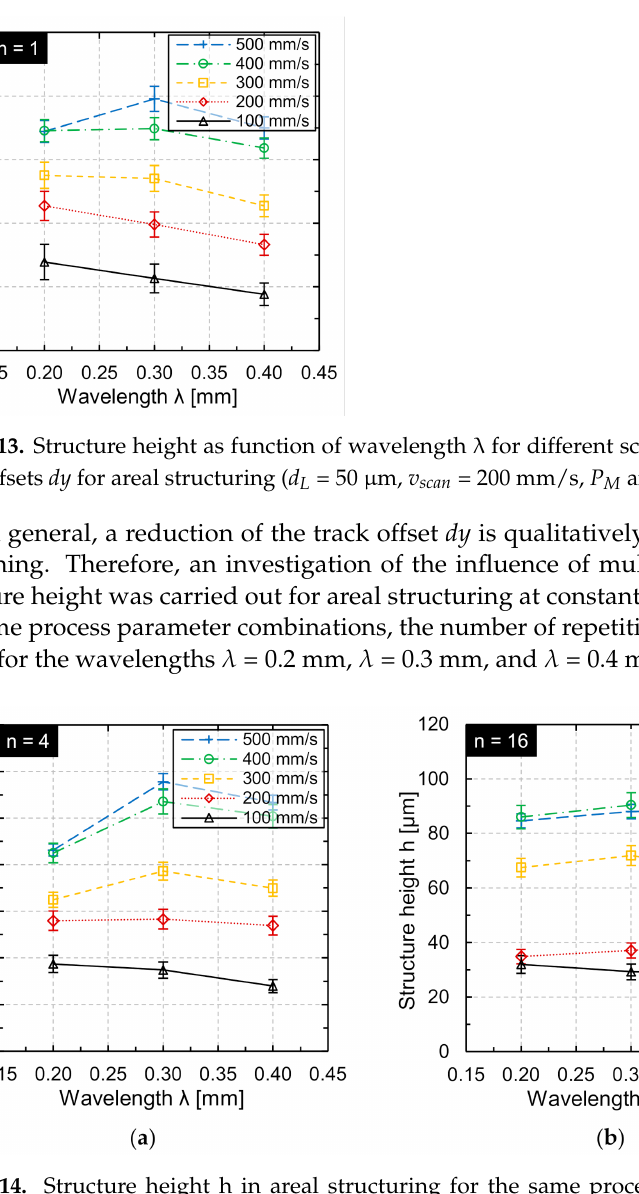
Figure 14. Structure height h in areal structuring for the same processing time as function of wavelength at adapted scan speed and track offset after ( a ) n = 4 repetitions and ( b ) n = 16 repetitions ( d L = 50 µ m, P M and P A adapted to v scan